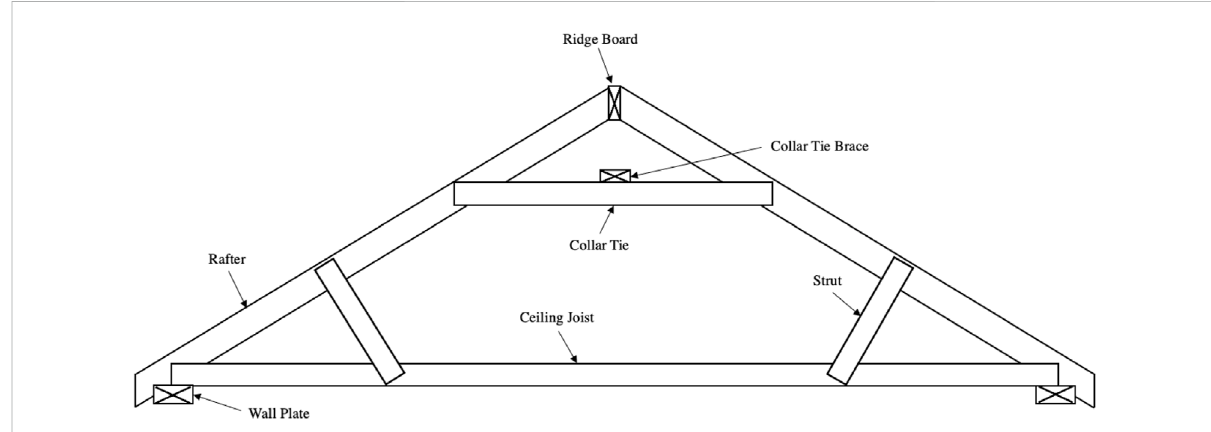
FIGURE 1 Sketch of a stick-built roof with all the members